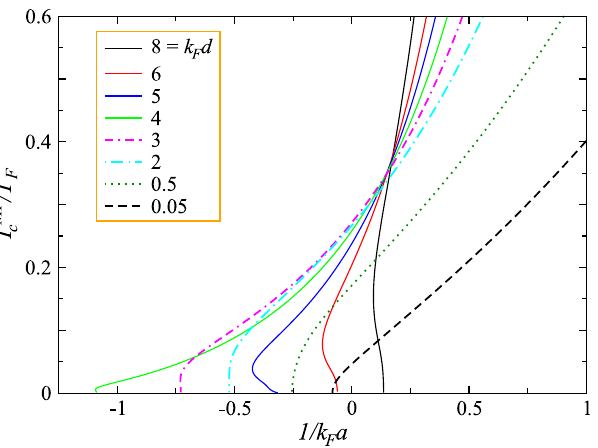
Figure 2. Mean-field solution of T cMF as a function of k a 1/ temperature superfluidity occurs for k F d = 5, 6 and